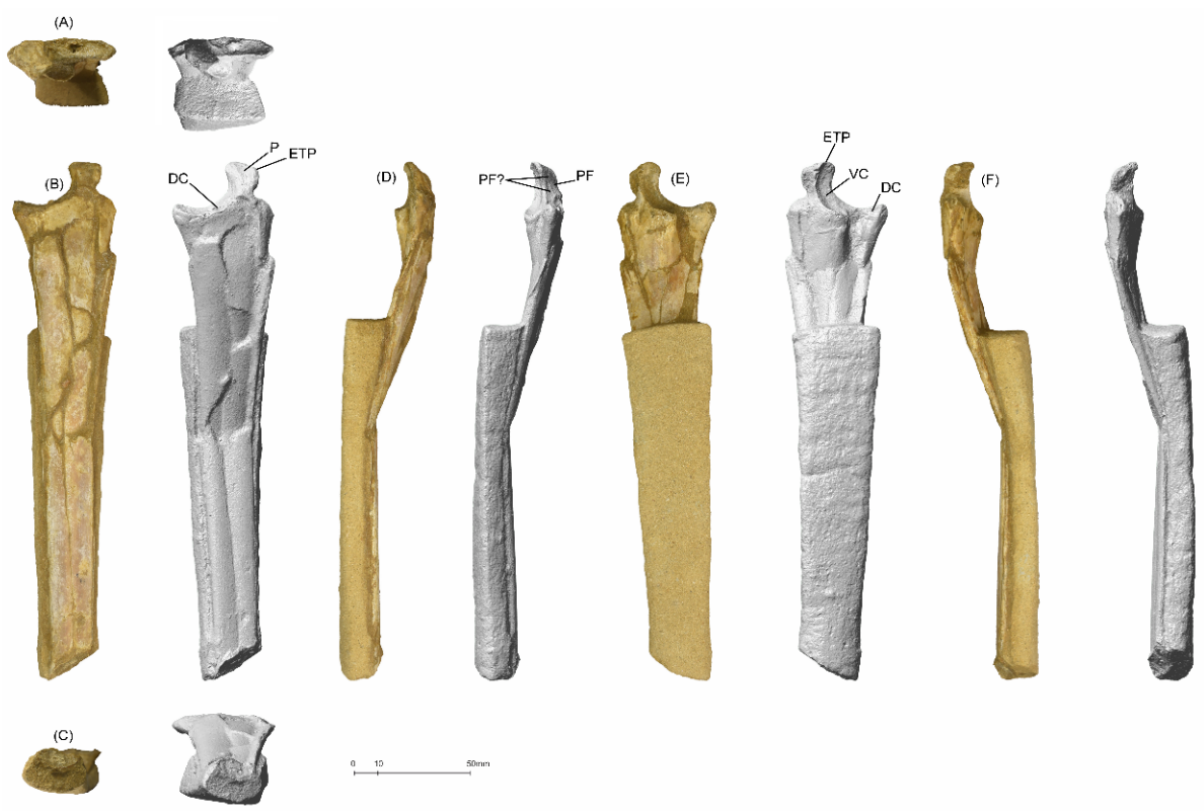
Figure 8. MGUAN-PA654 right manual digit IV phalanx 1 fragment. ( A ) proximal, ( B ) dorsal, ( C ) distal, ( D ) posterior, ( E ) ventral, and ( F ) anterior views. Abbreviations: DC, dorsal cotyle; ETP, extensor tendon process; P, protuberance; PF, pneumatic foramen; VC, ventral cotyle.